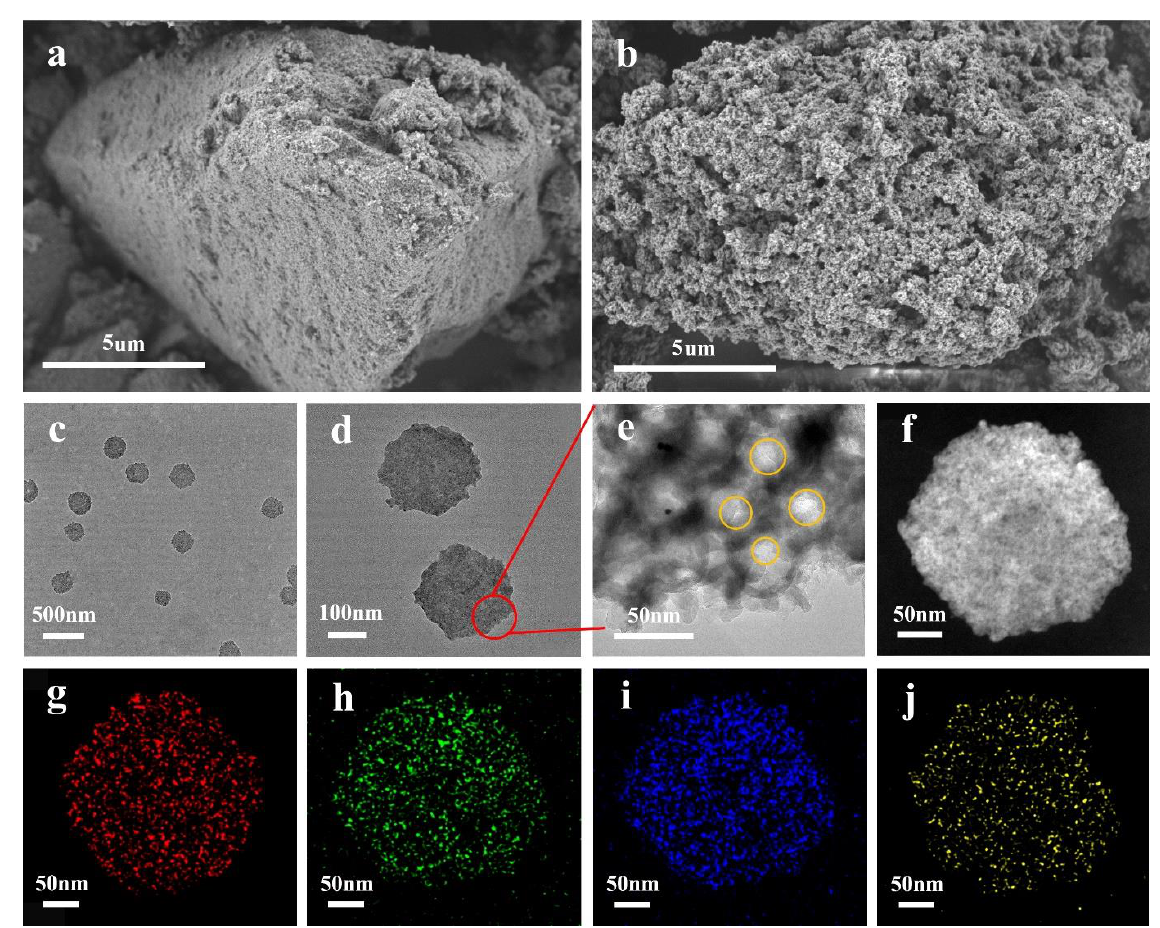
Figure 2. SEM images of ( a ) SiO 2 –CH 3 –CALB, ( b ) SiO 2 –CH 3 –CALB@PDA, ( c – e ) TEM images of SiO 2 –CH 3 –CALB@PDA and ( f – j ) elemental mapping analysis of SiO 2 –CH 3 –CALB@PDA (TEM).